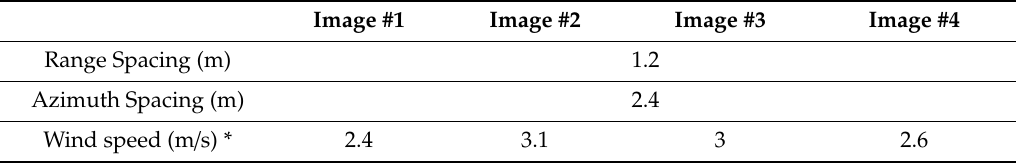
Position in SAR imagecorrectedfor azimuth shiftbywakeanalysis, i.e. SAR-basedshipcompensatedimage coordinates–wakeanalysis